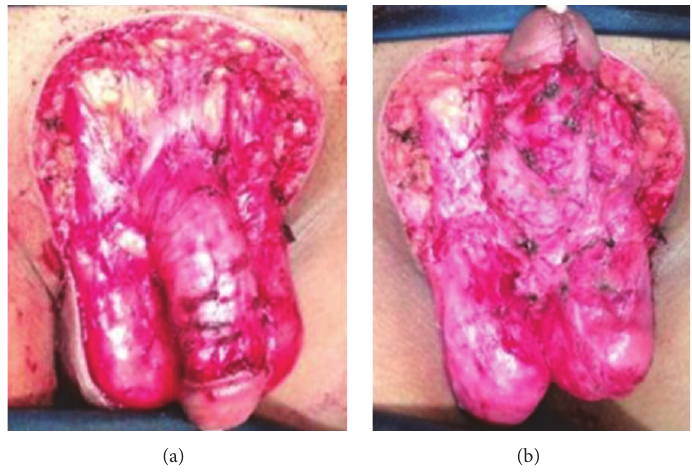
Figure 2: Wide excision on condyloma acuminata . (a) Dorsal; (b)